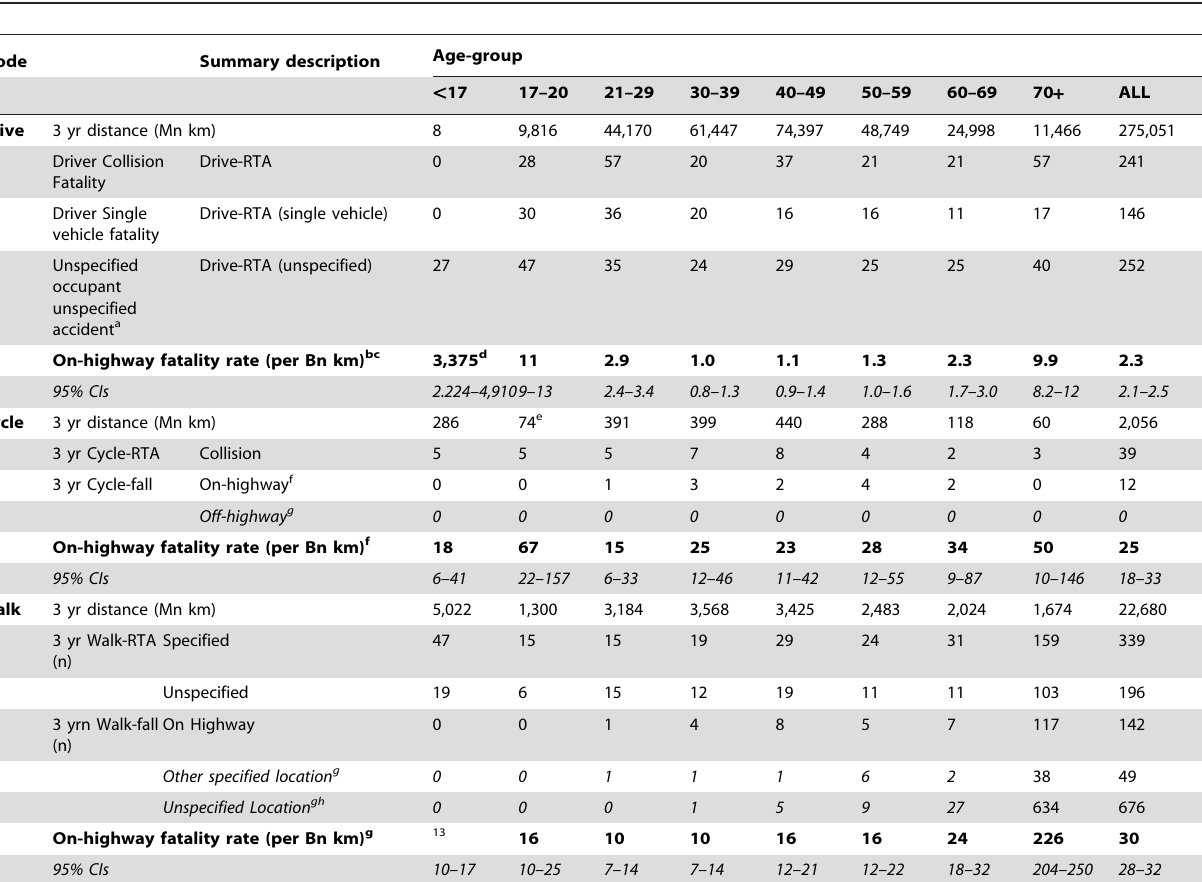
Table 2. Fatality numbers and rates per distance travelled, by travel mode, age, and type of incident, Females, England 2007–2009.